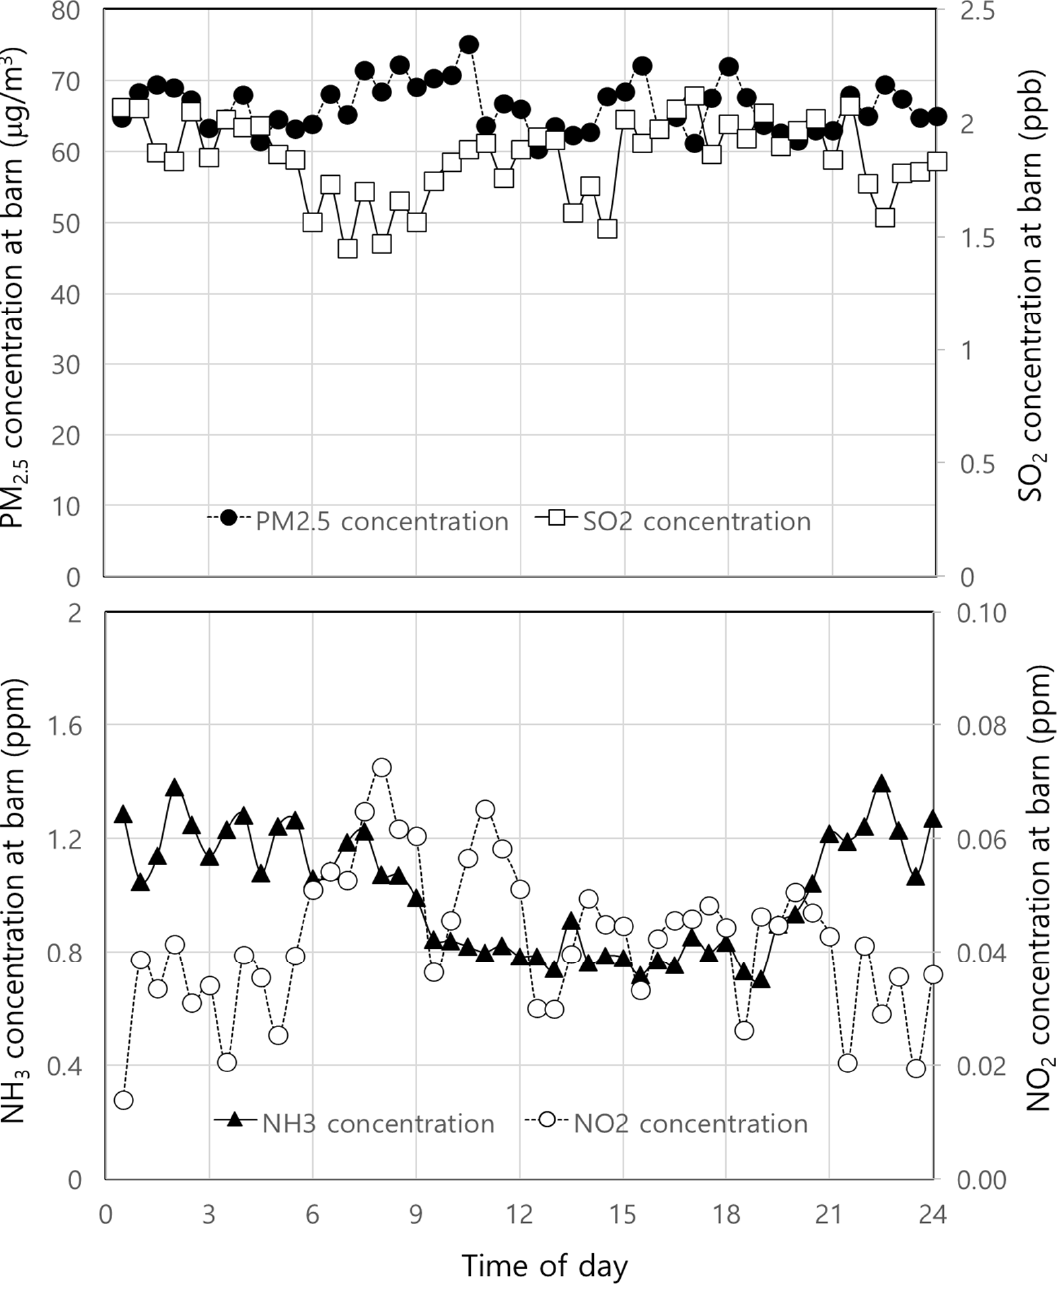
Figure 2. Diurnal profiles of the PM2.5 and sulfur dioxide concentrations (upper) and ammonia and nitrogen dioxide concentrations (bottom) in the barns.